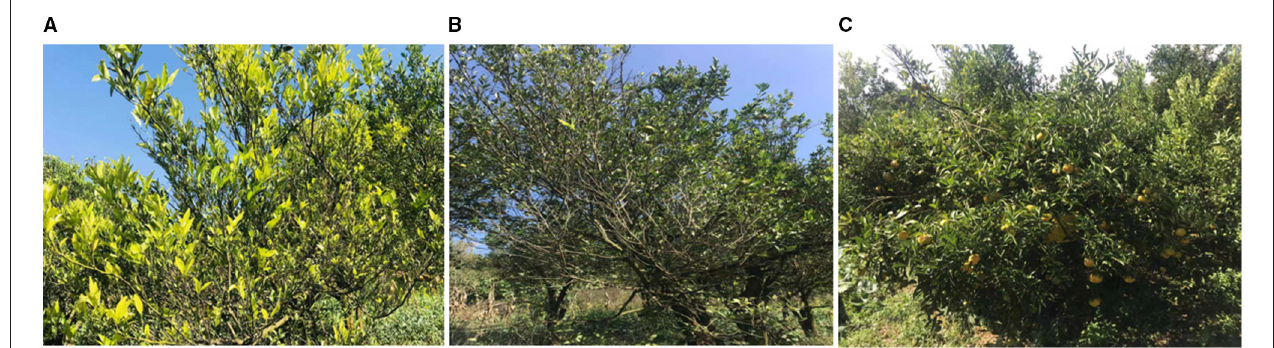
FIGURE 6 | Management of HLB in diseased citrus fields using endophyte Bacillus subtilis L1-21: In 2018, an experiment was performed to check the reduction of diseased severity in a citrus grove in Genma county, Yunnan Province, China. Trees showed diseased symptoms to a healthy state after 7–8 months regular treatment with indigenous citrus endophyte L1-21. (A) April 2018; (B) June 2018; and (C) November 2018 (Genma county, Yunnan Province, China).